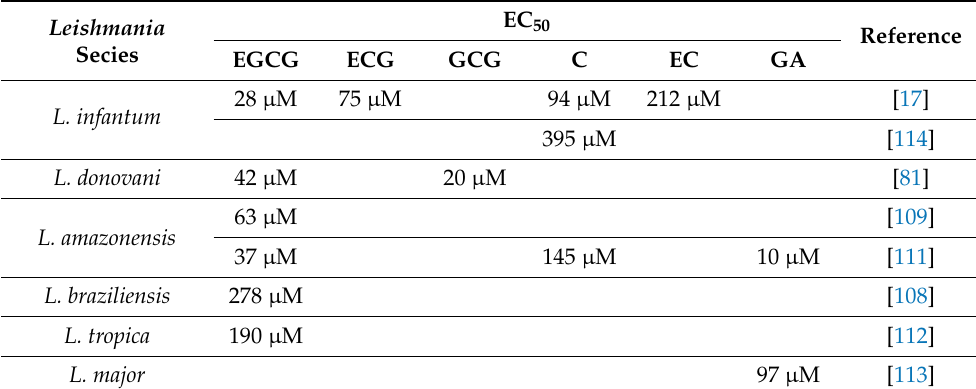
Table 6. In vitro activity of green tea polyphenols against